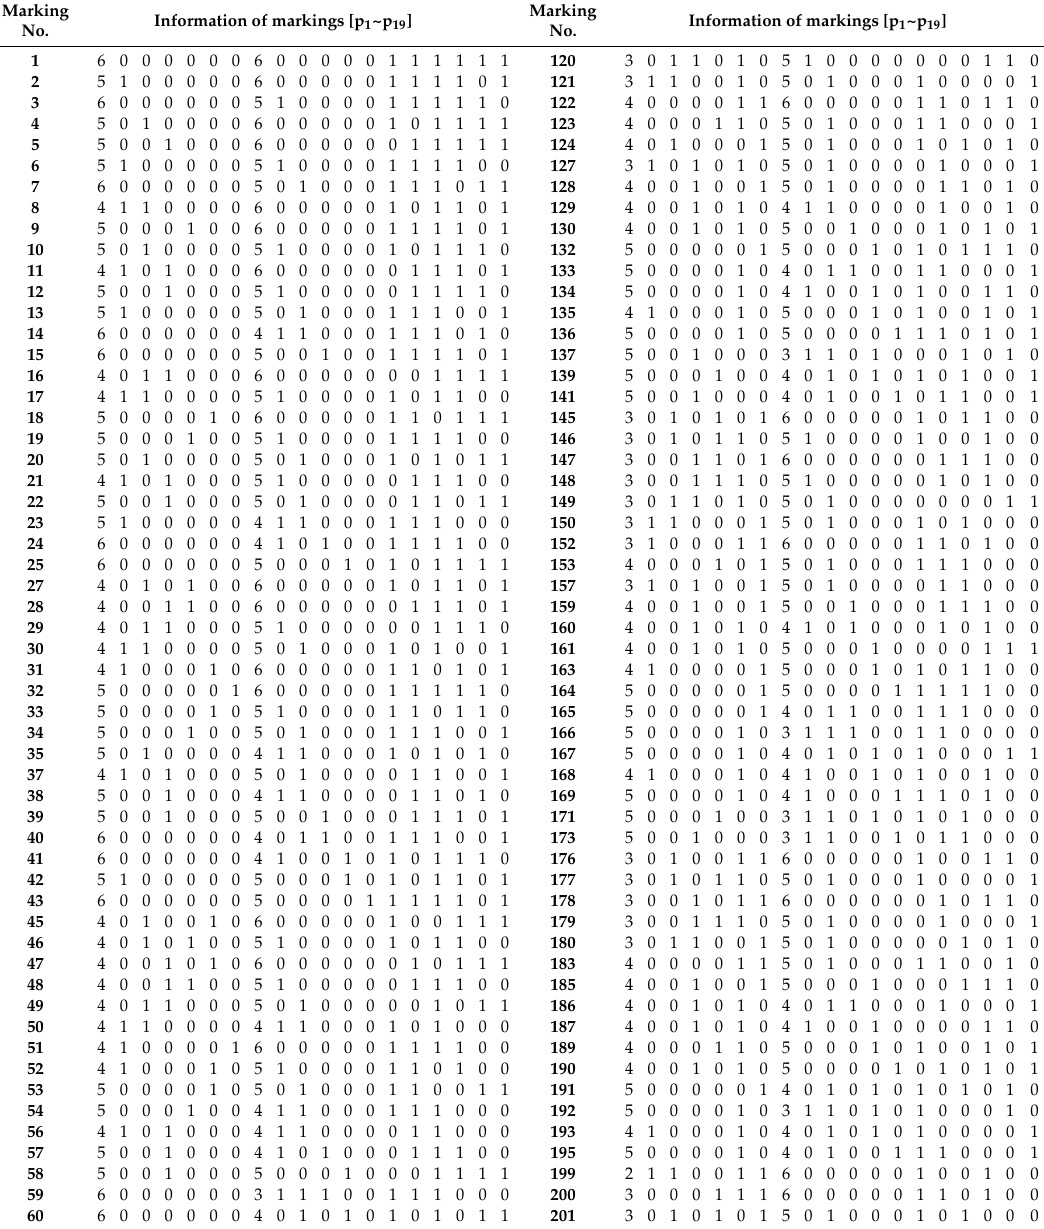
Table 5. The detailed information of all legal markings of Example